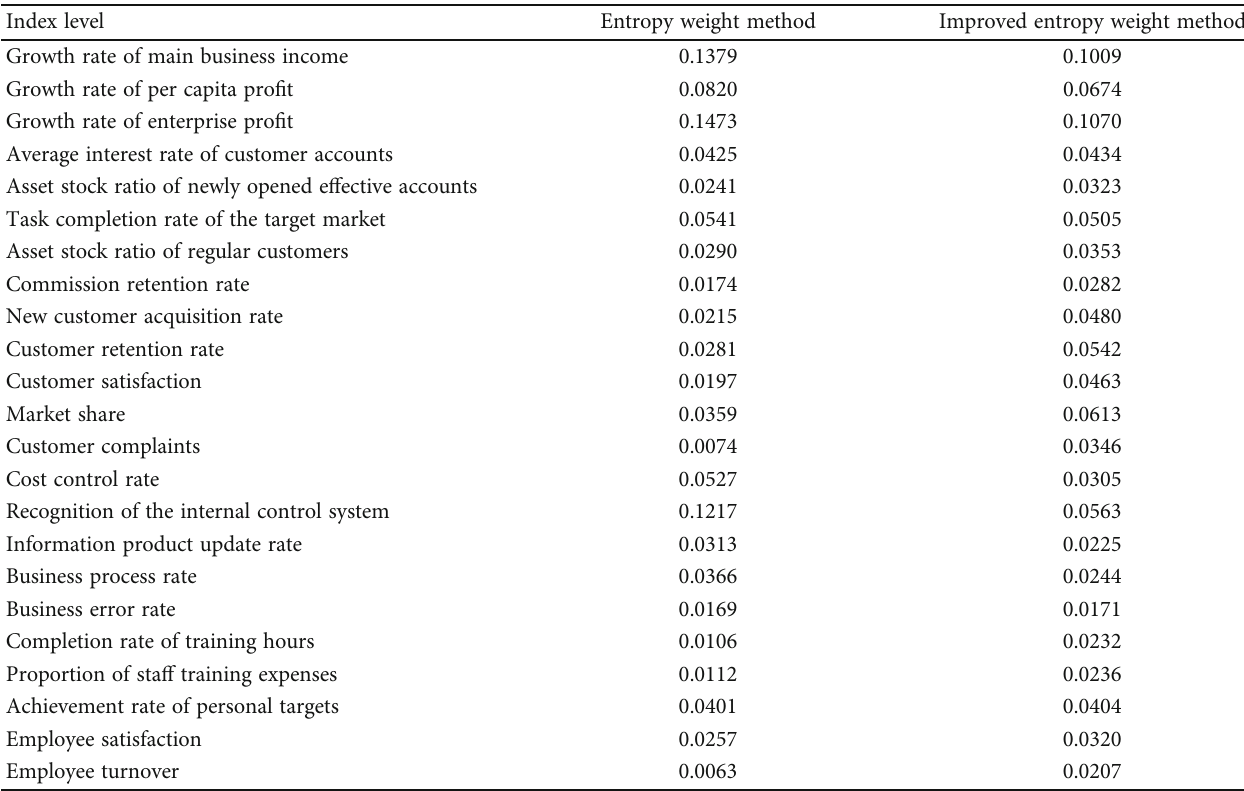
Table 5: Weights of traditional integrated weighting method and improved integrated weighting method in performance evaluation of securities industry.